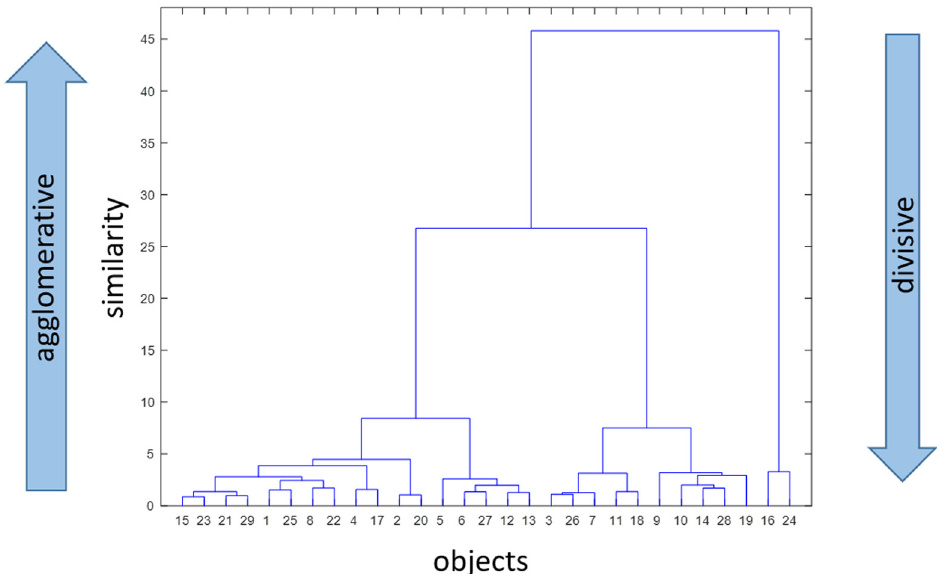
Figure 1: Example of a dendrogram obtained through HCA. The length of the branches indicates the similarity between the object ( how smaller the branches the more similar the sample )